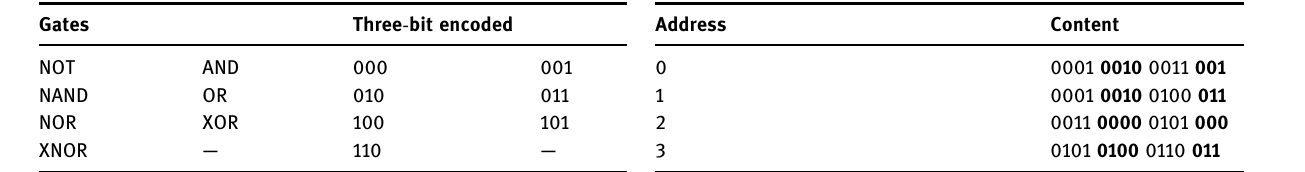
Table 3: BiCAM memory map for netlist fi le in Figure